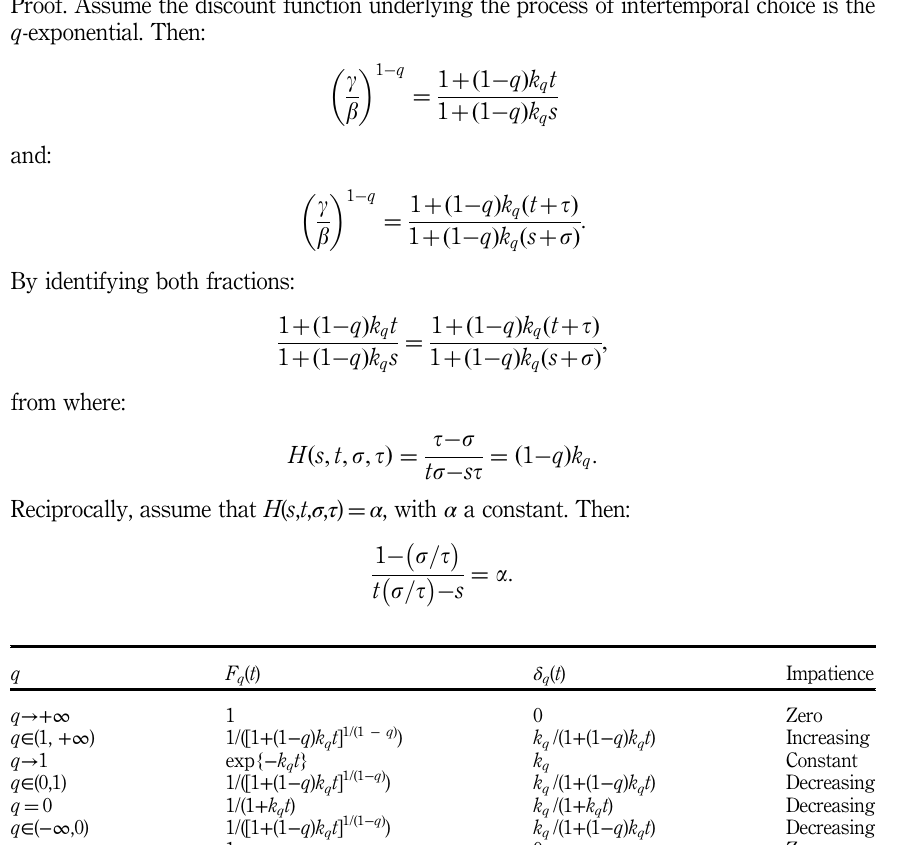
Table IV. Behavior of F q ( t ) according to different values of